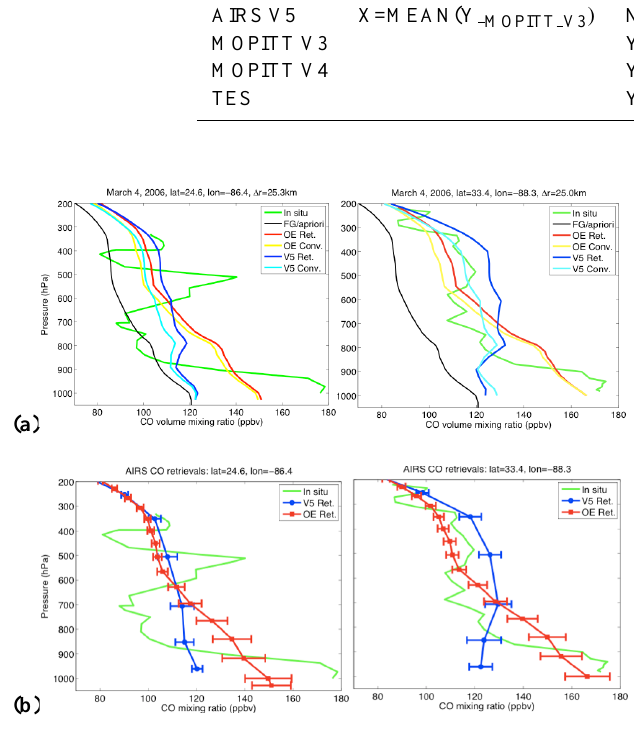
Figure 3b. Fig. 3. (a) INTEX-B DC-8 spiral profiles on 4 March 2006, over Gulf of Mexico (left) and over land to the west of Birmingham, AL near the fires (right), collocated with AIRS V5 CO (blue and cyan lines) and AIRS OE CO (red and orange lines). Cyan curves show the convolved in situ CO profile to the V5 retrievals and the orange curves show that convolved to the OE retrievals. (b) Similar to Fig. 3a except that Fig. 3b also shows the SDV values for AIRS OE and V5 CO retrievals within 200km circles surrounding the in situ